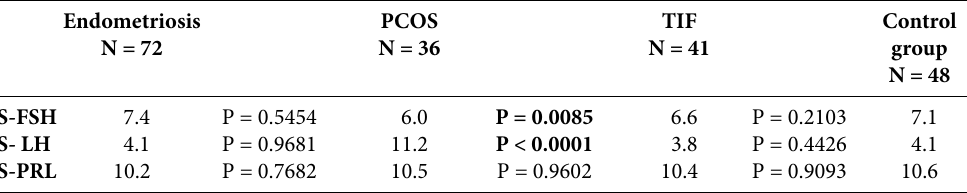
Table 3: Hormonal status of the participants